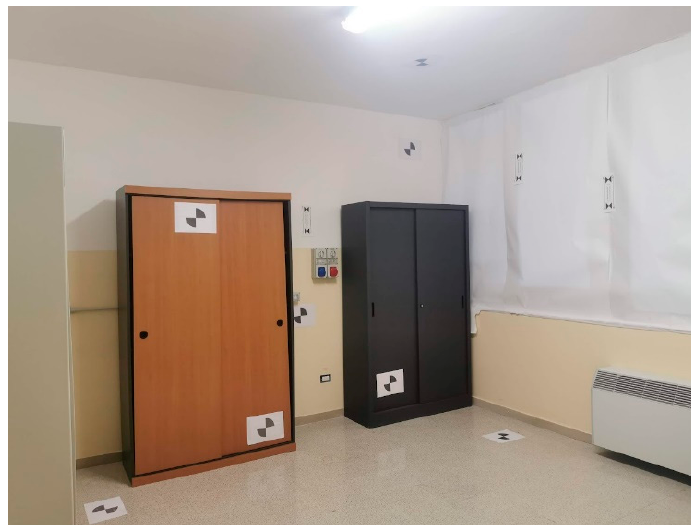
Figure 4. Detail of the room scanned in the third test.